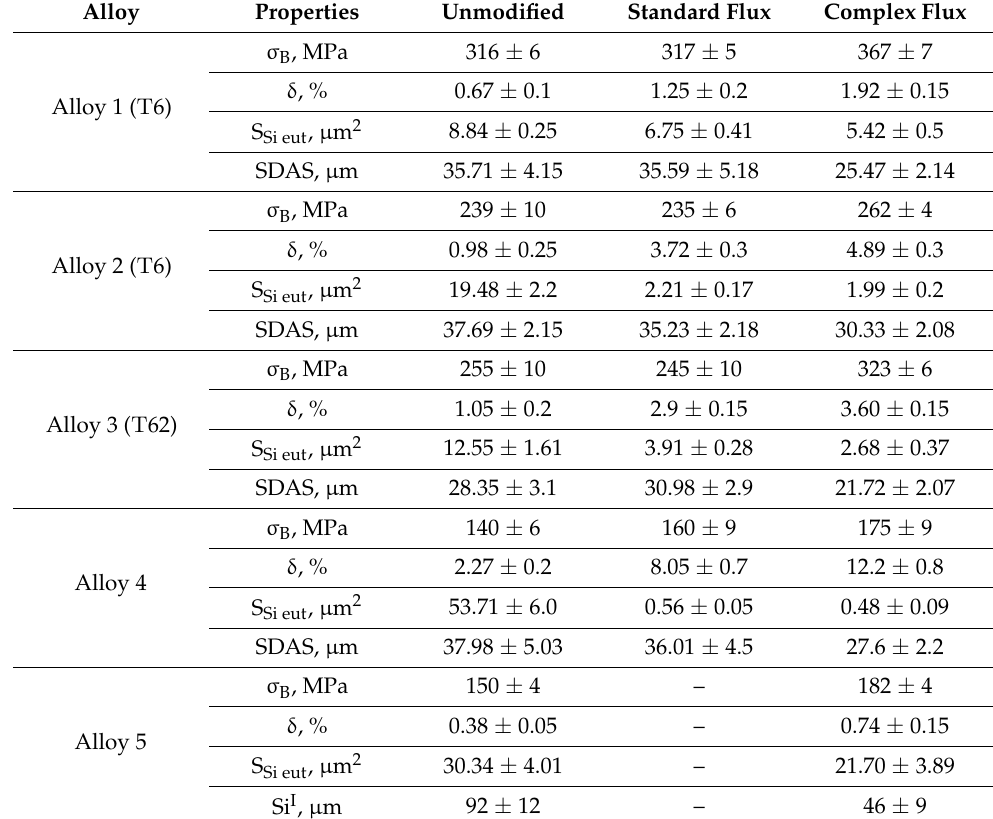
Table 2. Mechanical properties of Al–Si alloys, the average area of eutectic Si and the average size of primary Si, SDAS, depending on the type of treatment (sand casting).